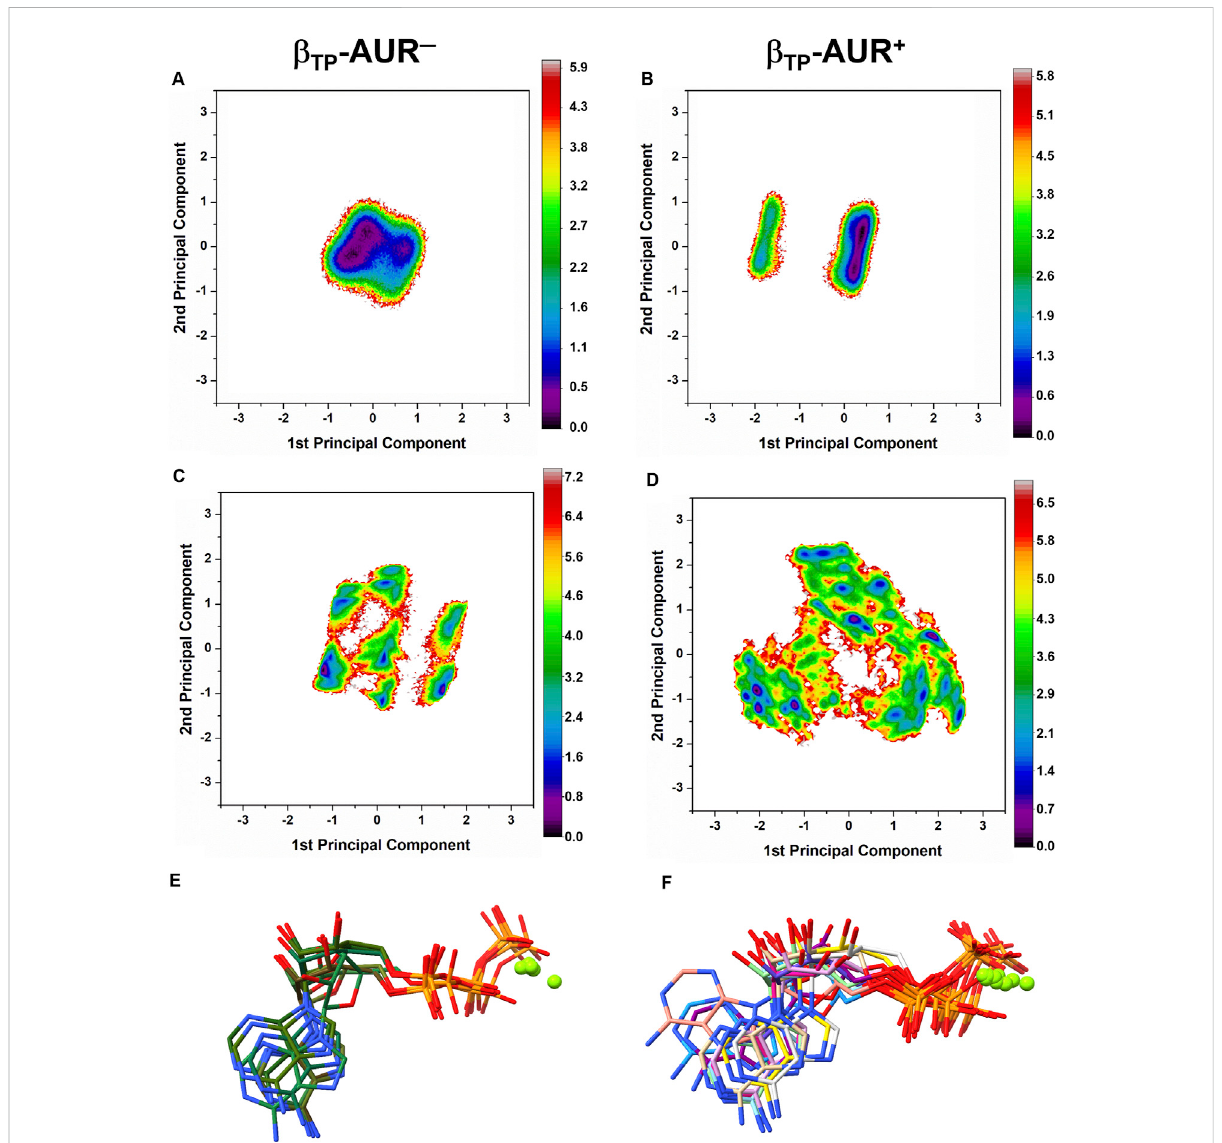
FIGURE 6 Dihedralanglefreeenergylandscapes(FEL)forthenucleotidebindingsitein β TP . (A) BackboneFELforAUR ─ . (B) BackboneFELforAUR + . (C) Side chainFELforAUR ─ . (D) SidechainFELforAUR + .FEL(in k B T units)wereobtainedfromadPCAprojectedontothe fi rsttwoprincipalcomponentsinthe absence(leftcolumn)andpresence(rightcolumn)oftheinhibitor.Residueswith χ angleswithin5 Åofthenucleotidein β TP (V 160 -V 164 ,R 189 ,T 190 ,R 260 , Y 311 , Y 345 , P 346 , Q 416 , F 418 , F 424 , T 425 ) were included in the analysis. (E) and (F) Representative MgATP conformations for AUR ─ and AUR + , respectively. Magnesium atoms are shown as green